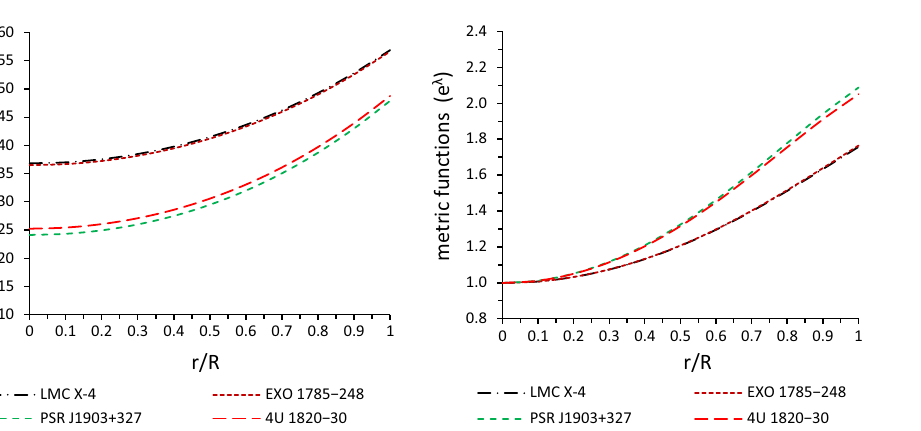
c = 0 . 01074, A = 0 . 4905, B = 1 . 2293, M = 1 . 3 M (cid:7) and R = 8 . 849kmforEXO1785-248,(iii) a = 0 . 005, b = 0 . 0004, c = 0 . 01481, A = 0 . 4654, B = 1 . 0551, M = 1 . 667 M (cid:7) and R = 9 . 438 km for PSR J1903+327, (iv) a = 0 . 0055, b = 0 . 0002, c = 0 . 0155, A = 0 . 44506, B = 1 . 1286, M = 1 . 58 M (cid:7) and R = 9 . 1 km for 4U 1820-30. These